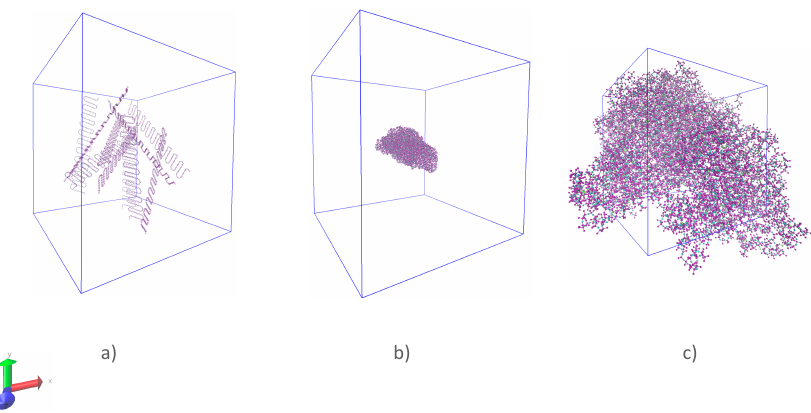
Figure 1. ( a ) Randomly distributed chains of silicone rubber in the periodic supercell; ( b ) chains of silicone rubber after crosslinking; ( c ) structure of silicone rubber before calculation of the thermal conductivity. Equation (1) was used as definition for the degree of